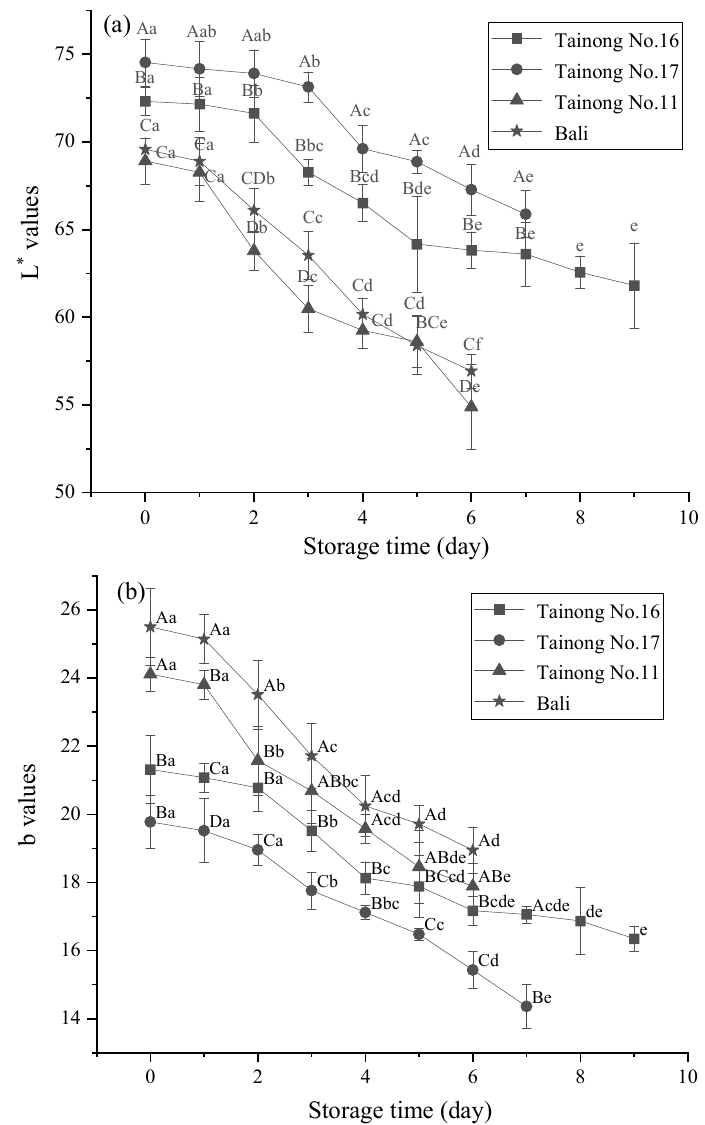
Figure 2. Changes in L* values ( a ) and b values ( b ) in freshly cut pineapple during storage. Different capital letters (A–D) indicate significant ( p < 0.05) differences in L* values and b values between varieties at the same storage time; different lowercase letters (a–f) indicate significant ( p < 0.05) differences in L* values and b values between the same varieties at different storage times.